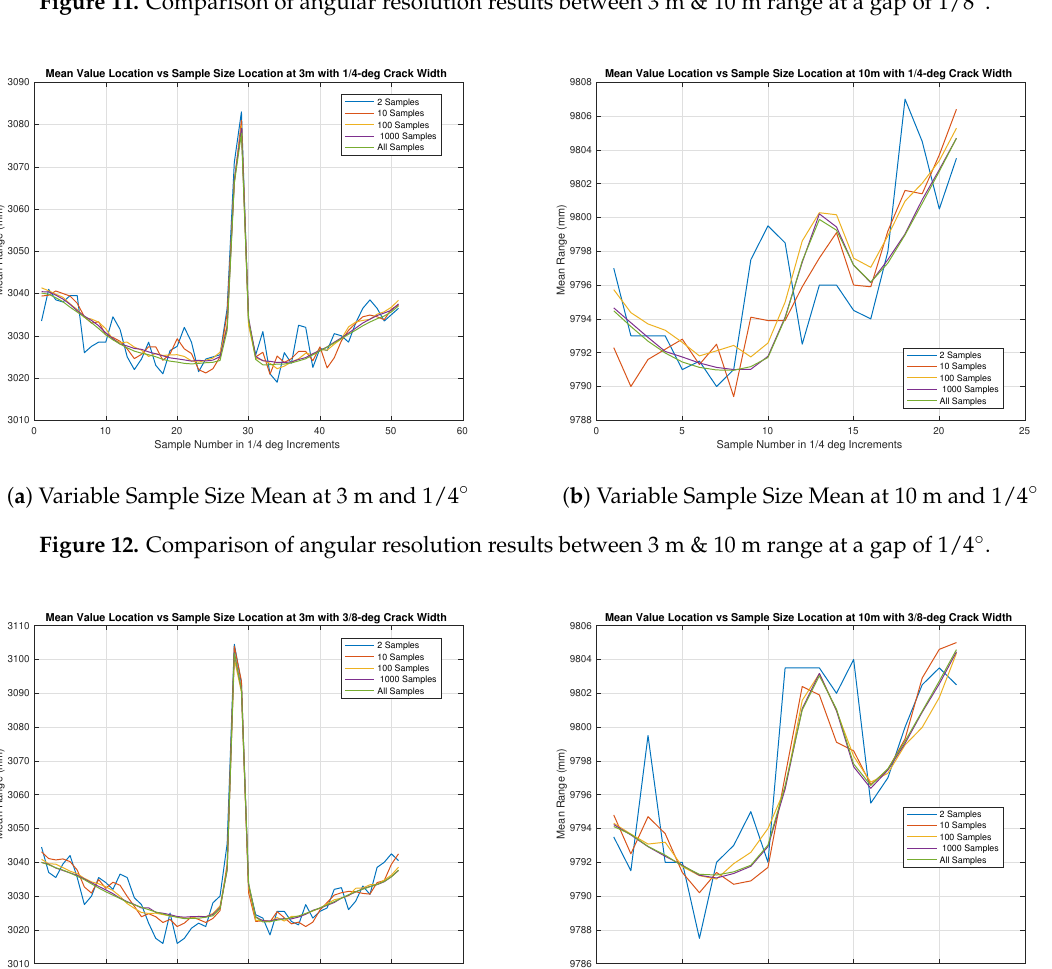
Figure 11. Comparison of angular resolution results between 3 m & 10 m range at a gap of 1/8 ◦ .